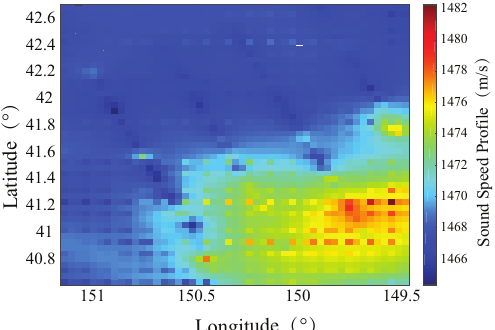
Figure 11. Regional sound speed profile for the depth of 250 m.